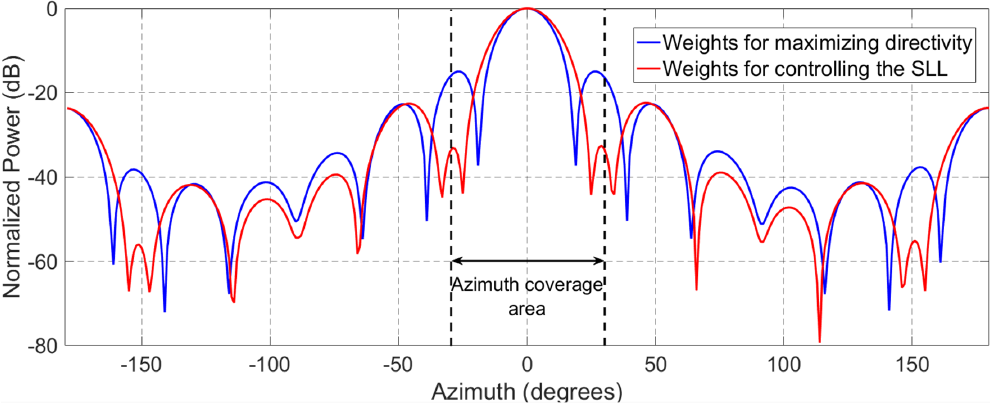
Figure 21. Comparison of azimuth radiation patterns of NULA with weights calculated for maximizing the directivity (blue) and for guaranteeing SLL < 15 dB